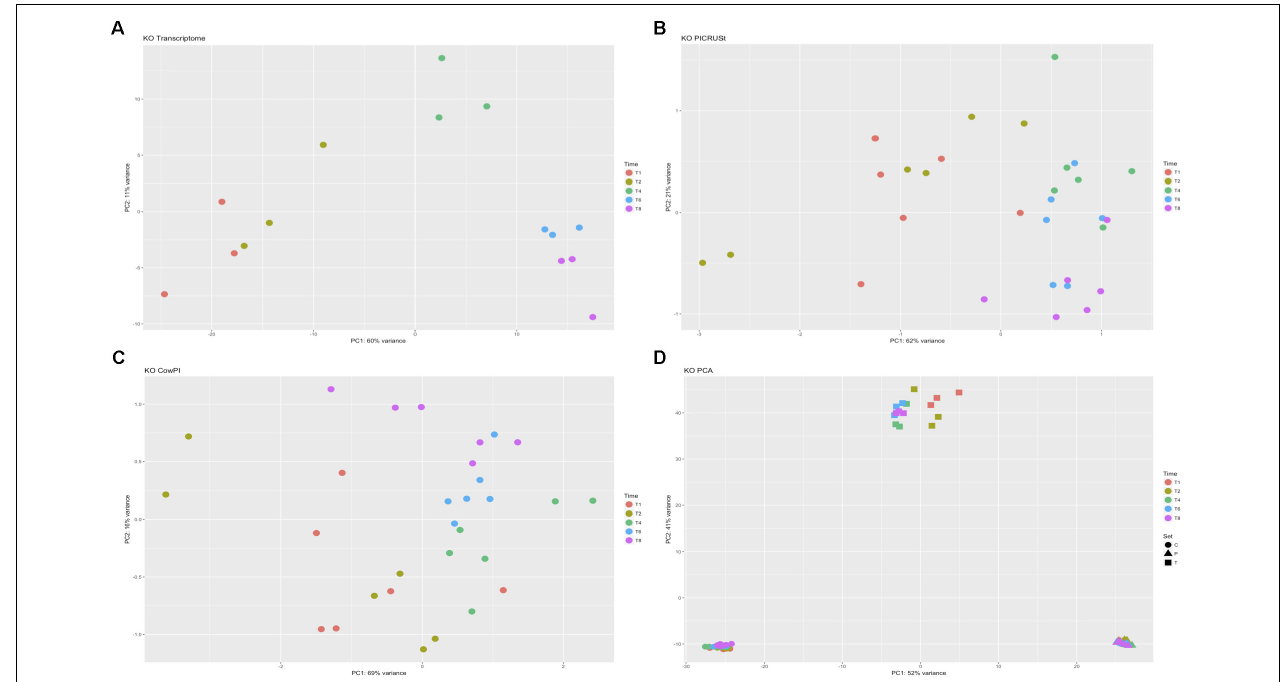
FIGURE 4 | Principal component analyses of KO counts present only in all three datasets. (A) Transcriptome dataset, (B) PICRUSt predicted KOs, (C) CowPI predicted KOs, (D) analysis including all samples blocked by time point and sample